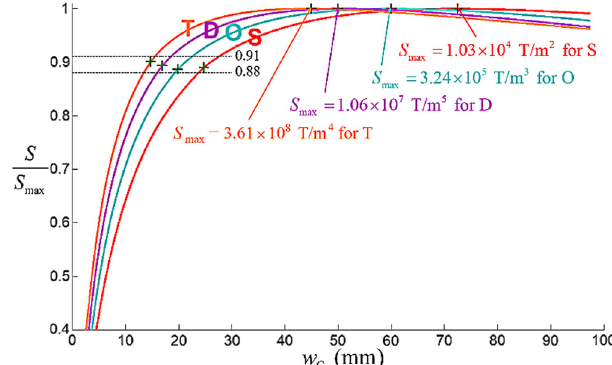
Insulated.FIG. 6. Strengthat80%alongthemagnetloadlinenormalizedto its maximum value versus coil width w ranging from sextupole to dodecapole (SODT) with iron